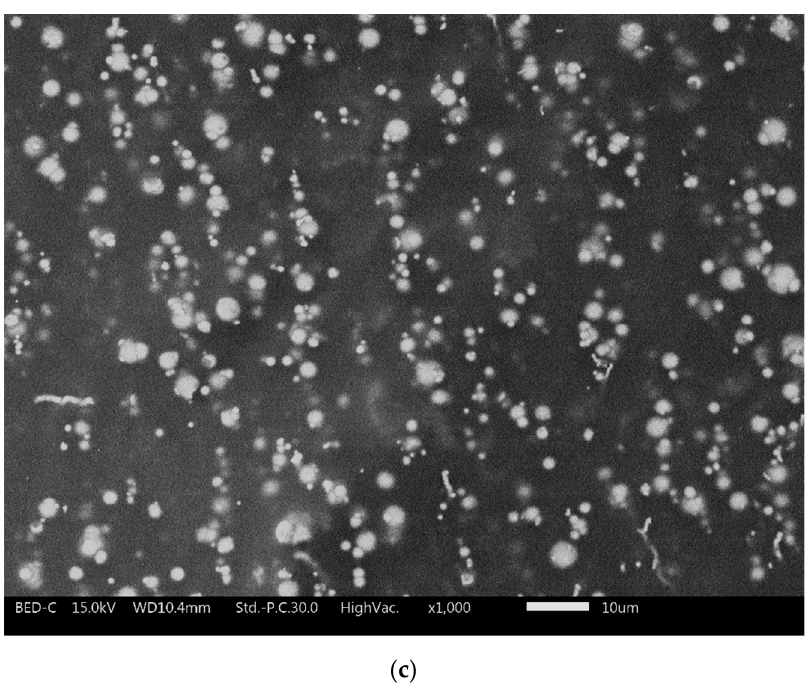
Figure 7. SEM images of MRE ( a ) isotropic at 500× magnifications ( b ) anisotropic at 500× magnifica ‐ tions ( c ) anisotropic at 1000× magnifications.